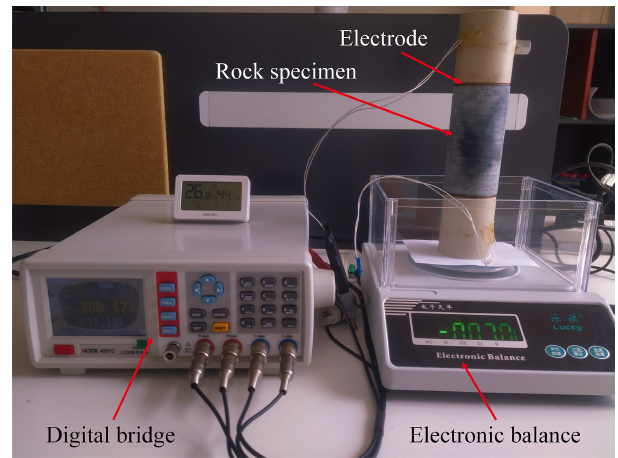
Figure 5. Water film evaporation and resistance curves with